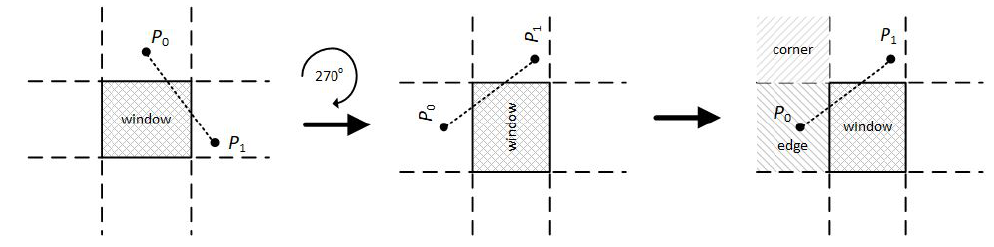
Figure 11. Applying 270 degrees clockwise rotation for moving the first line endpoint into the edge